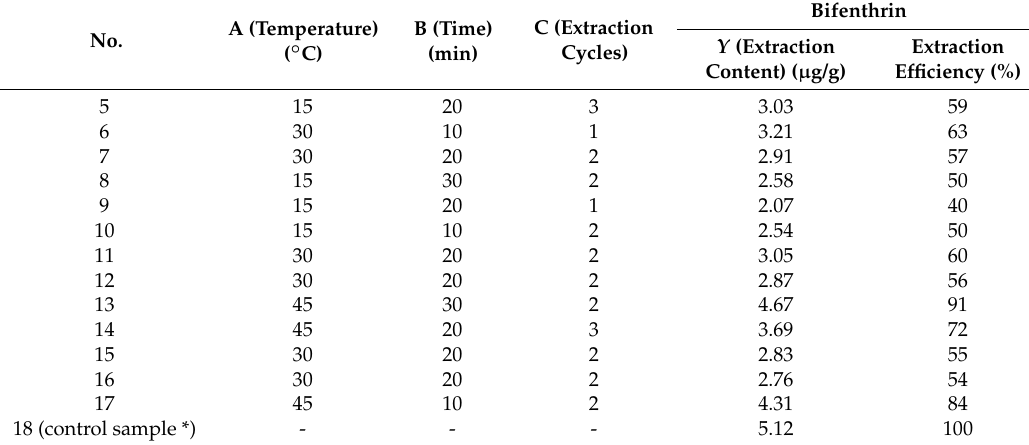
* indicated the sample without the butane treated process, but with the spraying of pesticides.